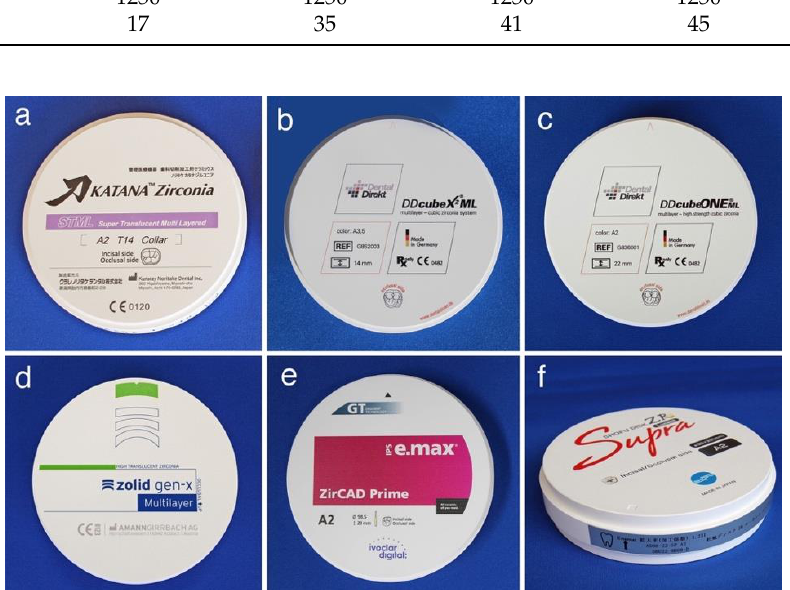
Figure 4. Zirconia CAD/CAM discs. ( a ) Katana ® Zirconia STML (Kuraray Noritake Dental, M5Y);